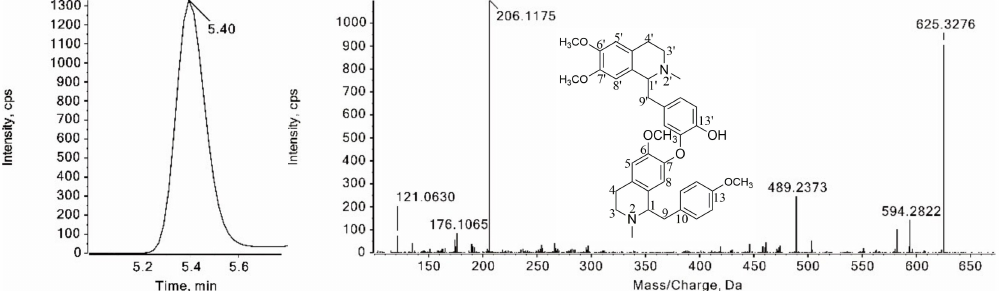
Figure 7. XIC and the MS/MS spectrum of